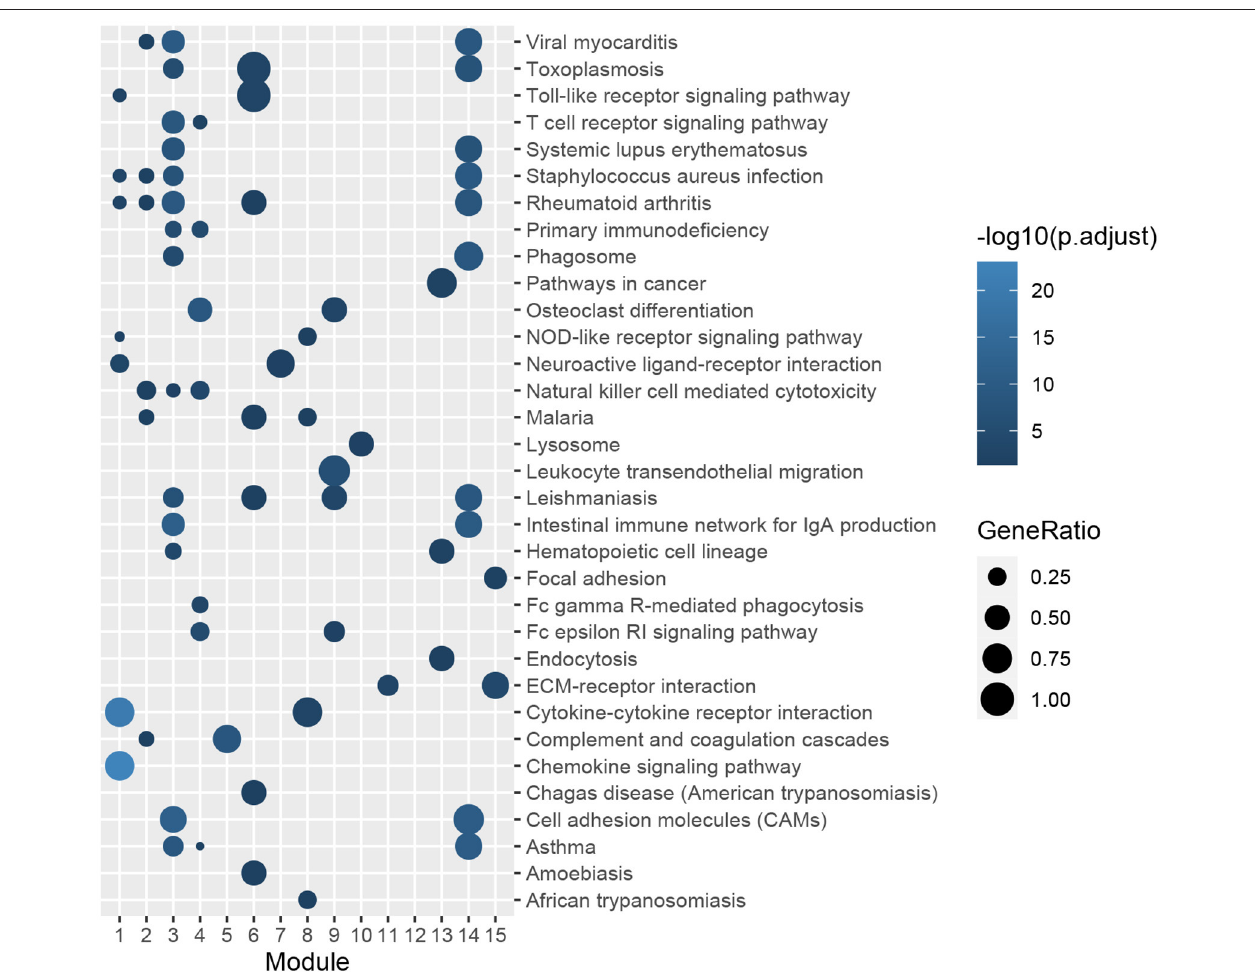
FIGURE 5 | KEGG pathway-enrichment analysis of genes in functional modules. The color gradation represents the significance of the enrichment for each indicated KEGG pathway. The enrichment increased significantly, when going from a dark shade to a light shade. The sizes of the circles indicate the proportions of genes in each functional module present among the entered KEGG